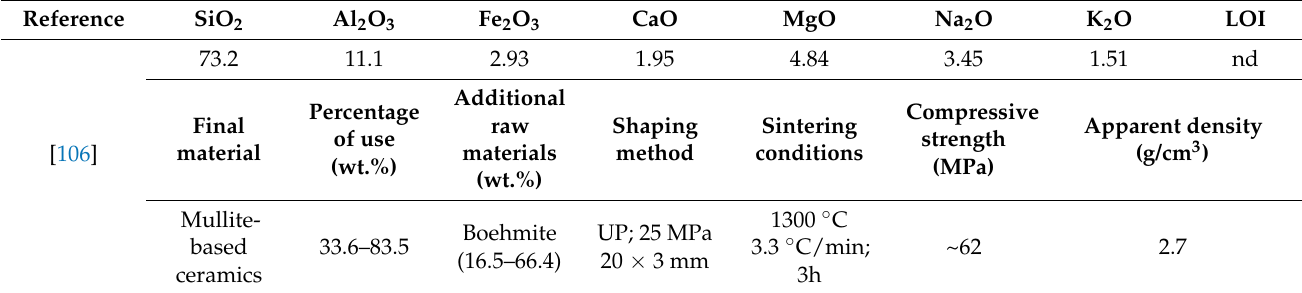
Table 10. Chemical composition (expressed wt.% oxide), processing parameters and technological properties of ceramic materials developed from molybdenum mining waste.